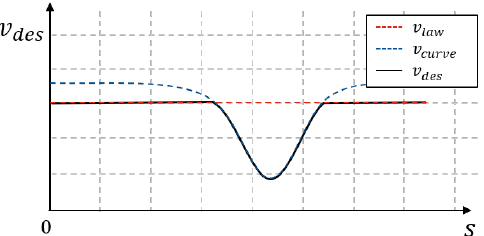
Figure 6. Along the path, the velocity is limited by the speed limit and the curvature. The curve approach velocity is part of the desired